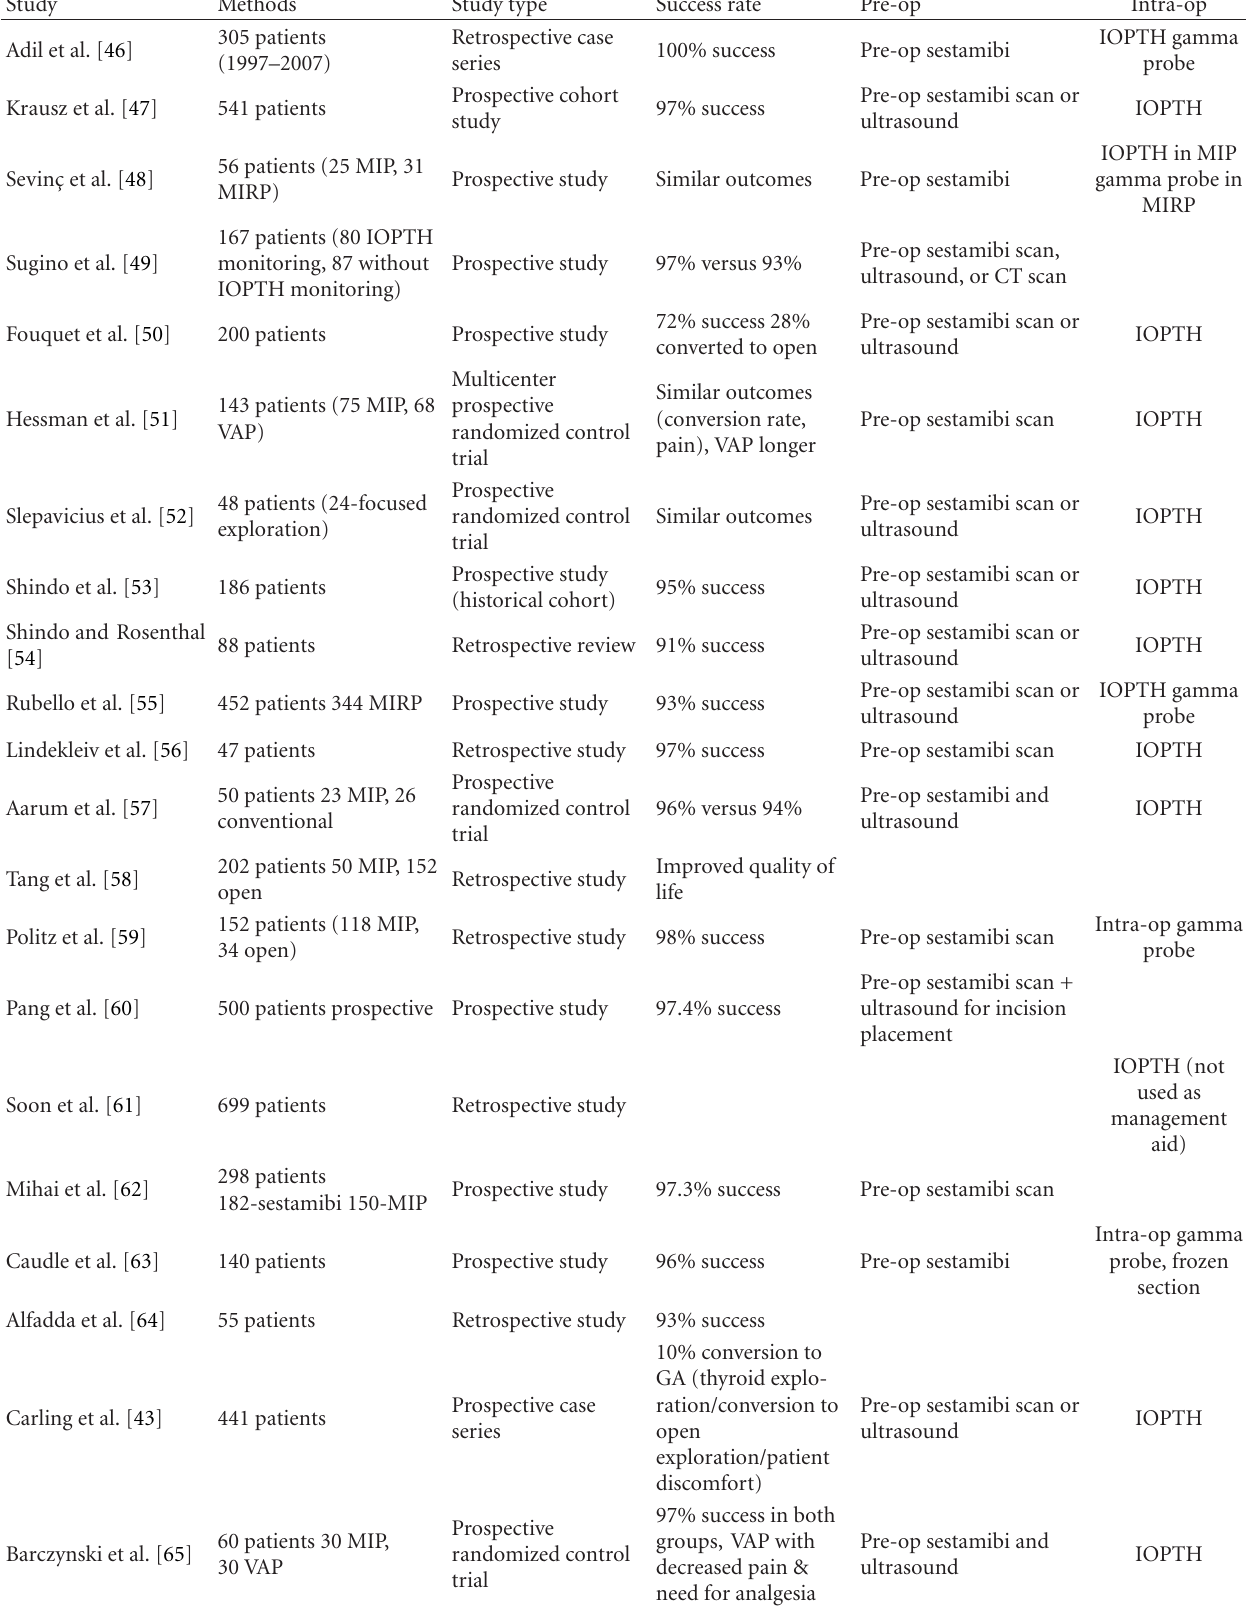
Table 1: Summary of studies describing technique and outcomes of minimally invasive